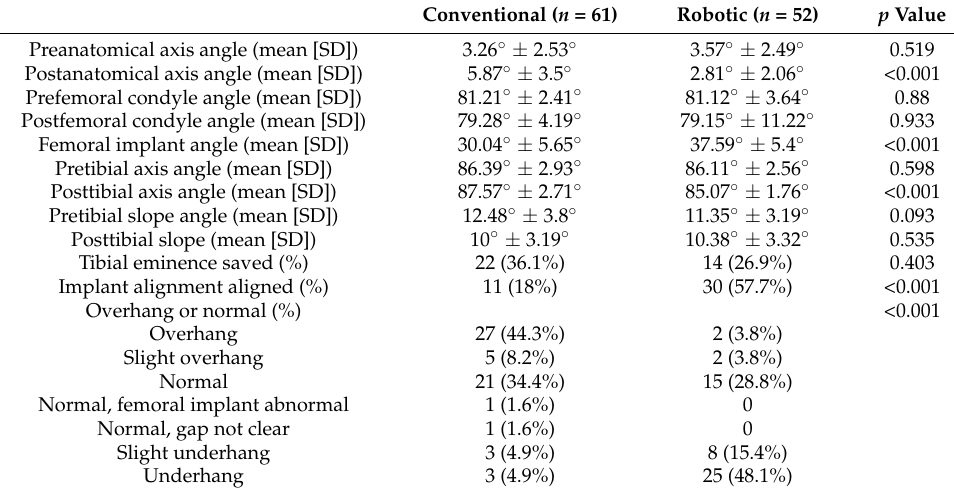
Table 1. Preoperative and postoperative anatomical alignment parameters and implant positioning in the robotic-assisted and conventional group